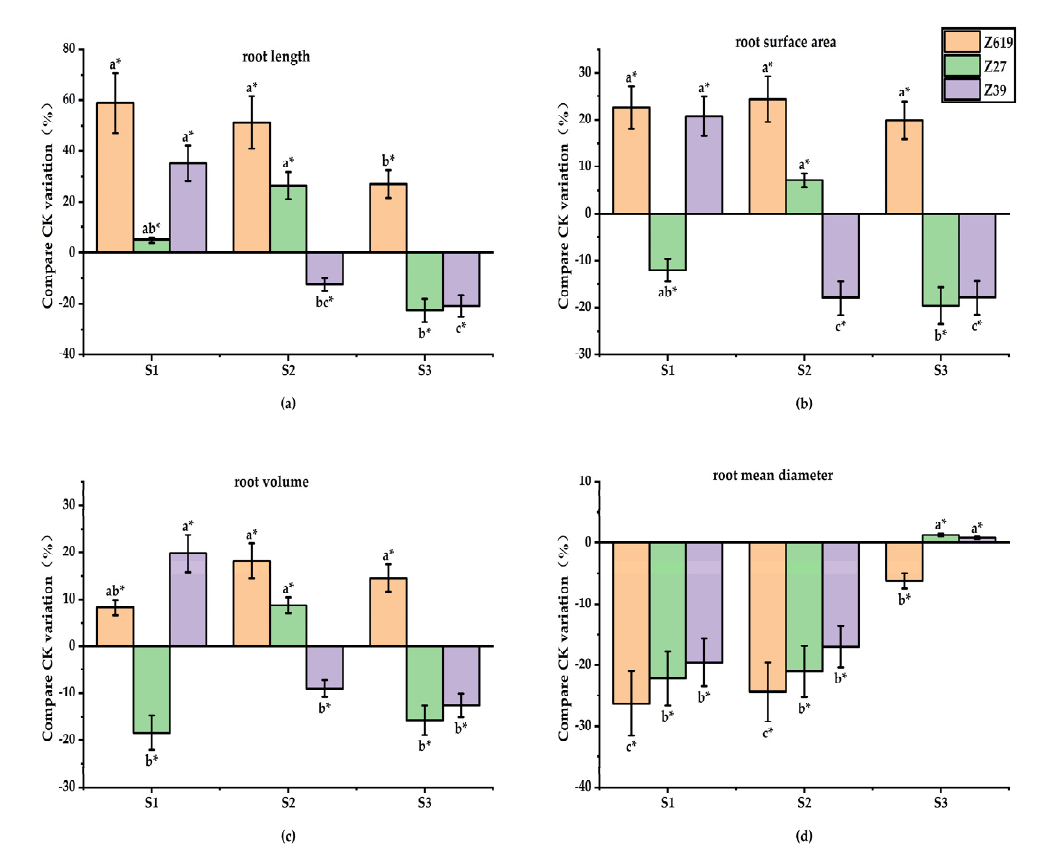
Figure 2. ( a ) Effects of different concentrations of salicylic acid on root length; ( b ) Effects of different concentrations of salicylic acid on root surface area; ( c ) Effects of different concentrations of salicylic acid on root volume; ( d ) Effect of different concentrations of salicylic acid on root mean diameter. * Different lowercase letters in the figure indicate that different treatments of the same variety have significant differences at p < 0.05.